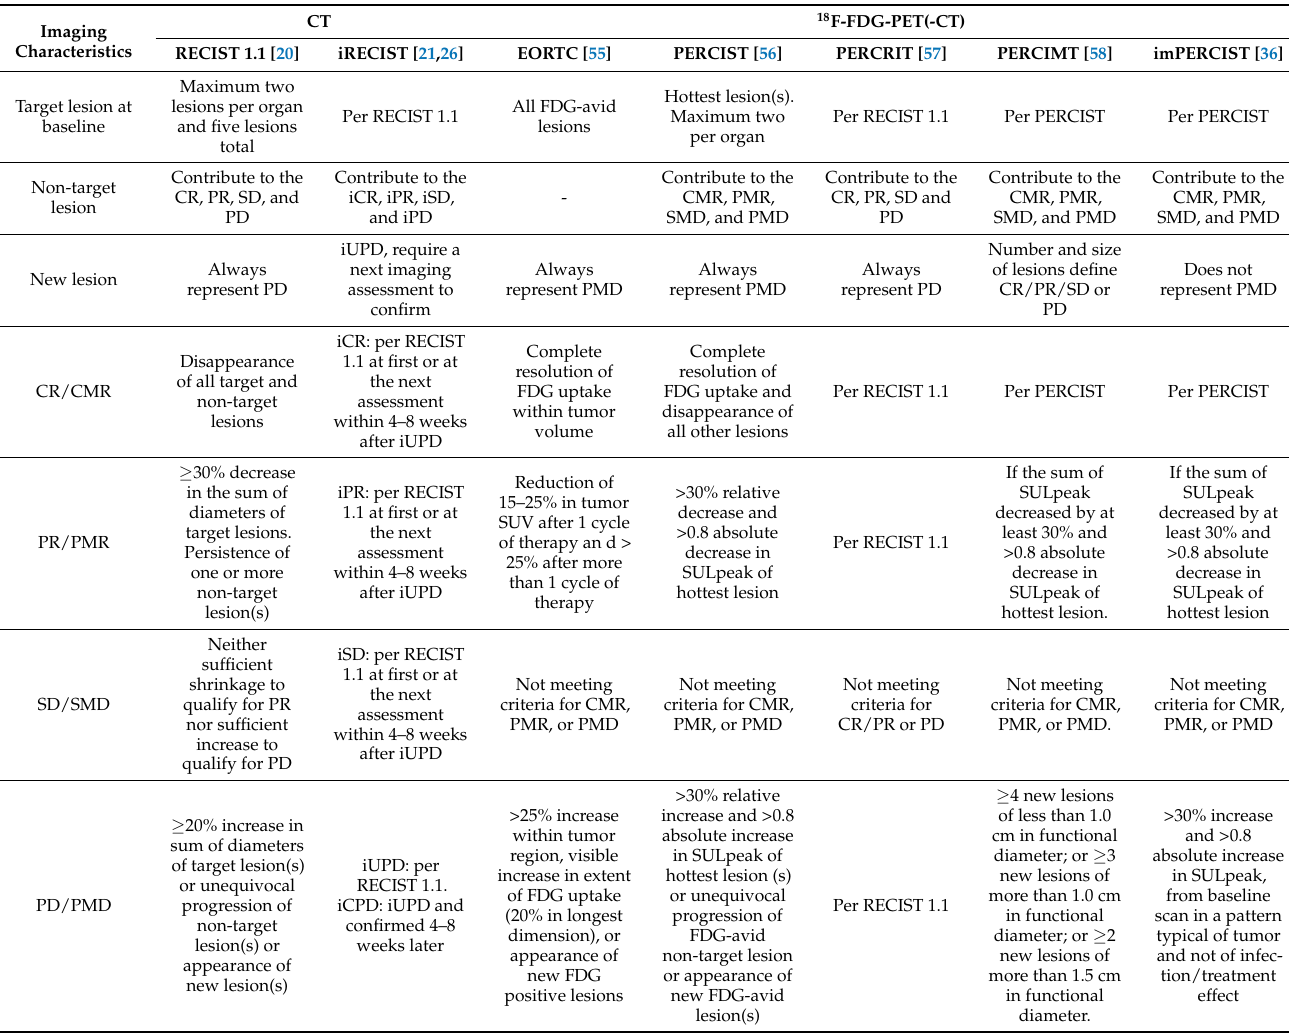
Table 2. Overview of response evaluation